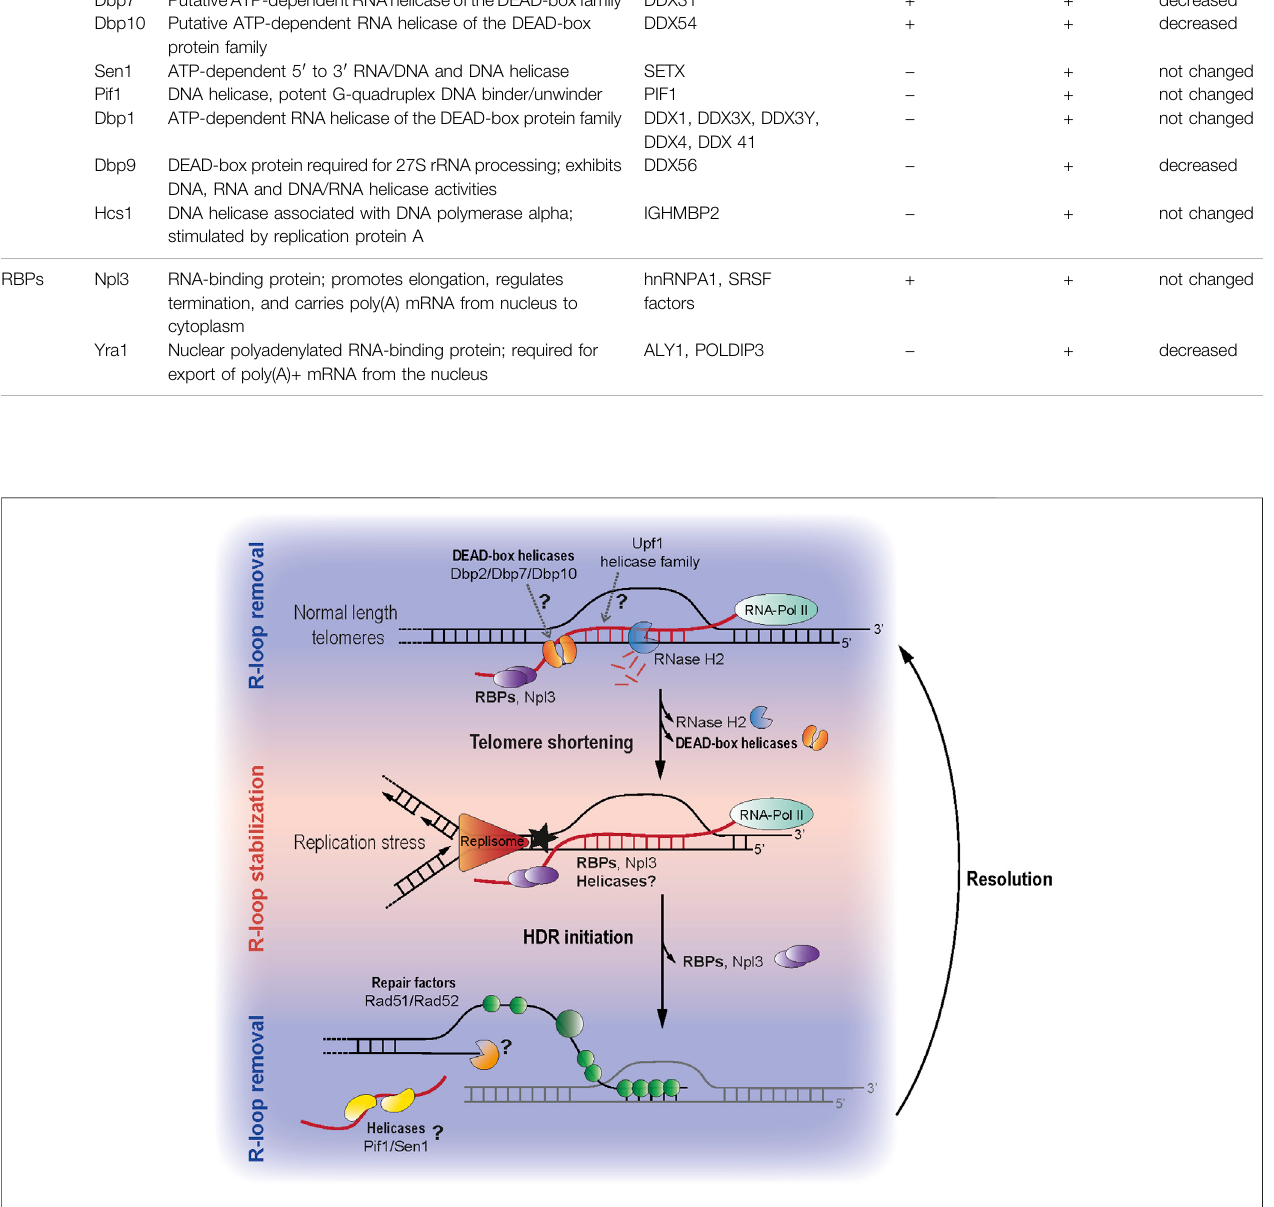
FIGURE 1 | (Top) At normal length telomeres TERRA is transcribed and degraded in a cell cycle dependent manner. Along with RNase H2, other telomere interacting proteins (Dbps and Upf1 as well as the ssRNA binding protein Npl3) may contribute to the removal of TERRA (middle) When telomeres become critically shortened,TERRAR-loopsaccumulateattelomereswhichpromotesHDRmediatedtelomeremaintenance.TheabsenceofRNaseH2atshorttelomerescontributesto R-loop stability, however there may also be proteins which actively promote R-loop formation and stabilization. Npl3, for example can stabilize R-loops at short telomeres, how it changes from an R-loop preventer to promoter remains elusive. R-loops at short telomeres may drive replication stress and this may in turn trigger HDR.(bottom)AlthoughtelomericR-loopsareimportanttotriggerHDR,itislikelythattheirremovalisalsorequiredeithertoallowproperresectionand/orre-annealingof the 3 ′ strand that was elongated. Helicases such as Pif1 and Sen1 are prime candidates to carry out such a